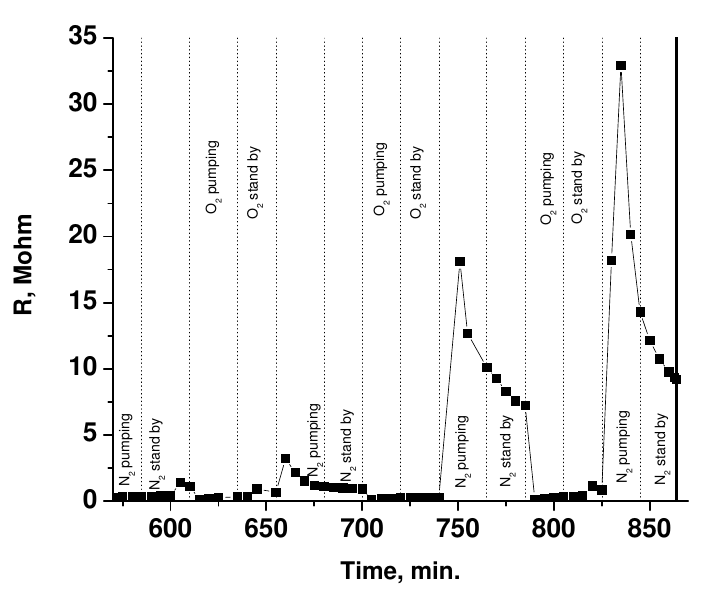
Fig. 5 Dependence of the surface resistance of Pt-YSZ sample in an atmosphere of differing oxygen content (fourth day). The sample is the same as that whose resistance is shown in Fig. 2 for 550 min. The temperature of measurement is further increased, because at a temperature 1065-1075 K, there is no effect of the gas change on the resistance. Shown is the transition from increased resistance to decreased resistance in